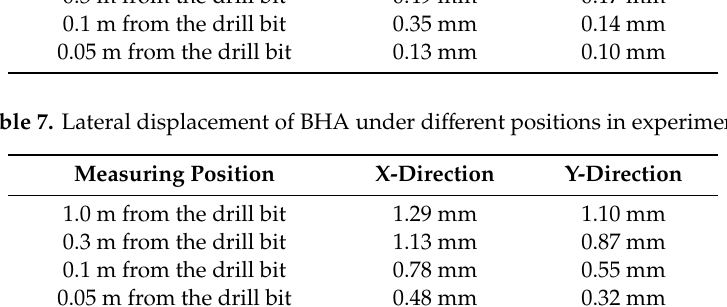
m, 0.3 m, 0.1 m, and 0.05 m respectively. 0.3 m, 0.1 m, and 0.05 m respectively.